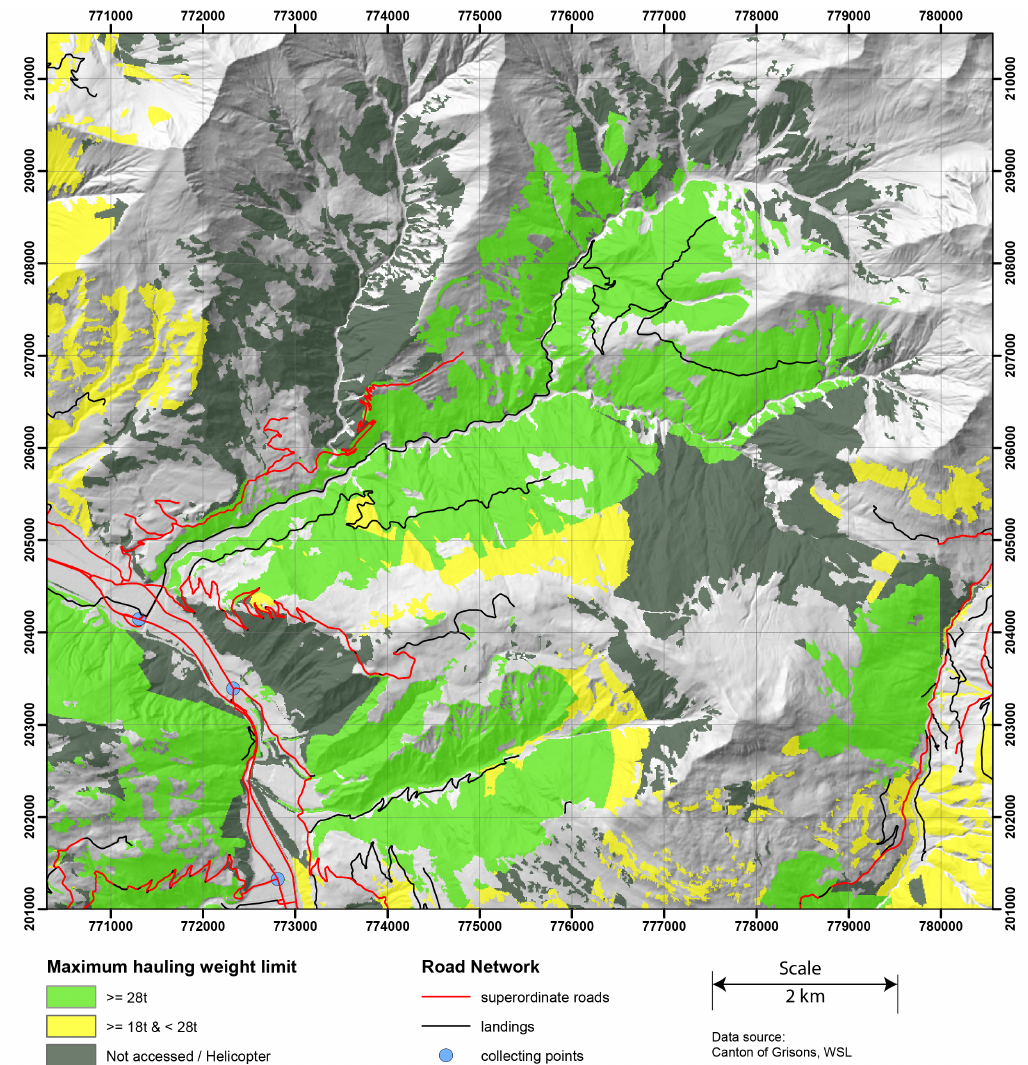
Figure 11. Extract of the maximum hauling weight limit map (region near Schiers in canton of